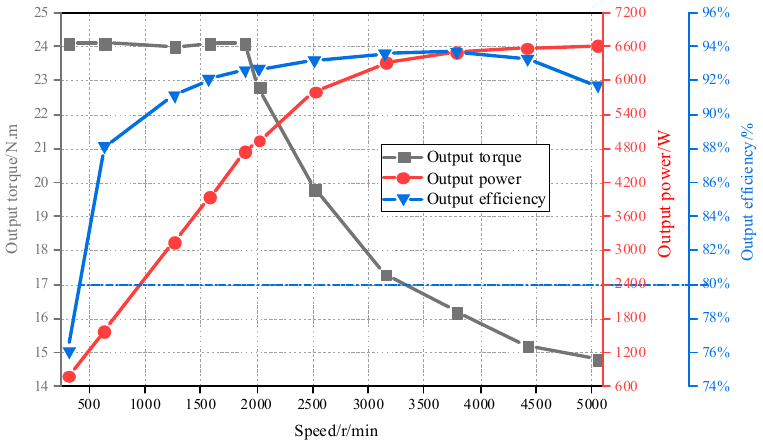
Figure 16. Mechanical characteristic curves of the motor.